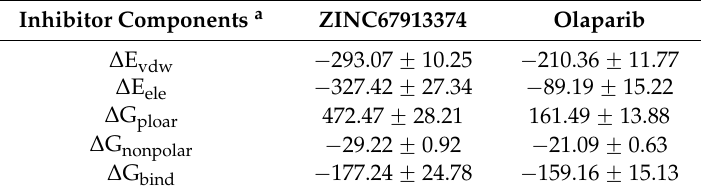
Table 2. Binding free energy (kJ/mol) of the potential PARP1 inhibitor and